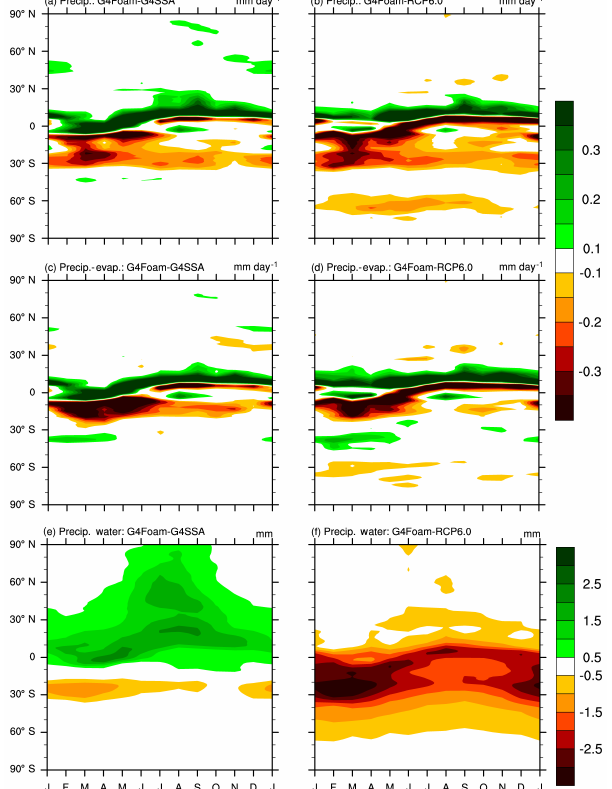
Figure 9. 2030–2069 monthly mean annual cycle of zonal mean precipitation (mmday − 1 ) for (a) G4Foam minus G4SSA and (b) G4Foam minus RCP6.0, precipitation minus evaporation (mmday − 1 ) for (c) G4Foam minus G4SSA and (d) G4Foam minus RCP6.0, and total precipitable water (mm) for (e) G4Foam minus G4SSA and (f) G4Foam minus RCP6.0.